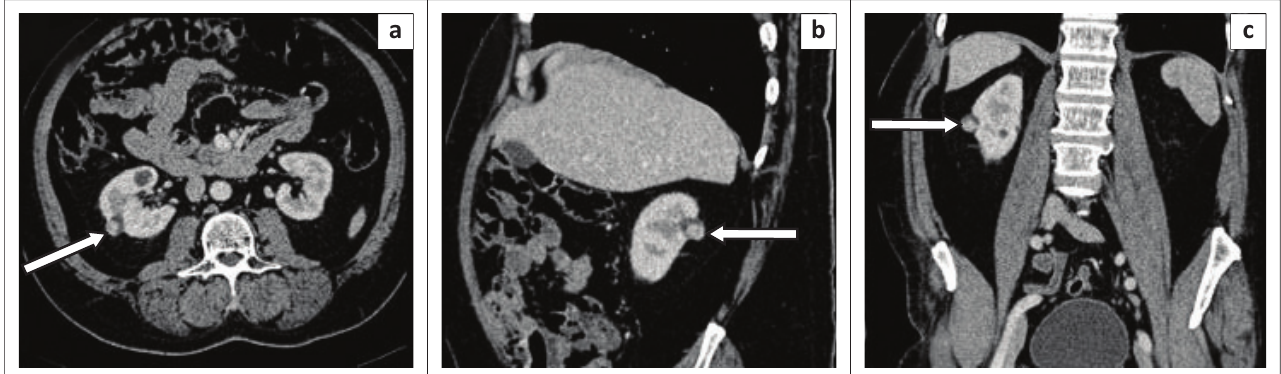
FIGURE 6: Non-renal cell carcinoma (RCC) benign renal tumour. Portovenous phase-enhanced computed tomography (CT) scan (a) axial, (b) sagittal and (c) coronal demonstrates a small exophytic rounded cystic lesion with a large uniformly enhancing solid component in the right renal mid pole (white arrow). No associated fat stranding. This lesion was assessed as RCC at CT scan. Post-nephrectomy histology results showed a benign leiomyoma.